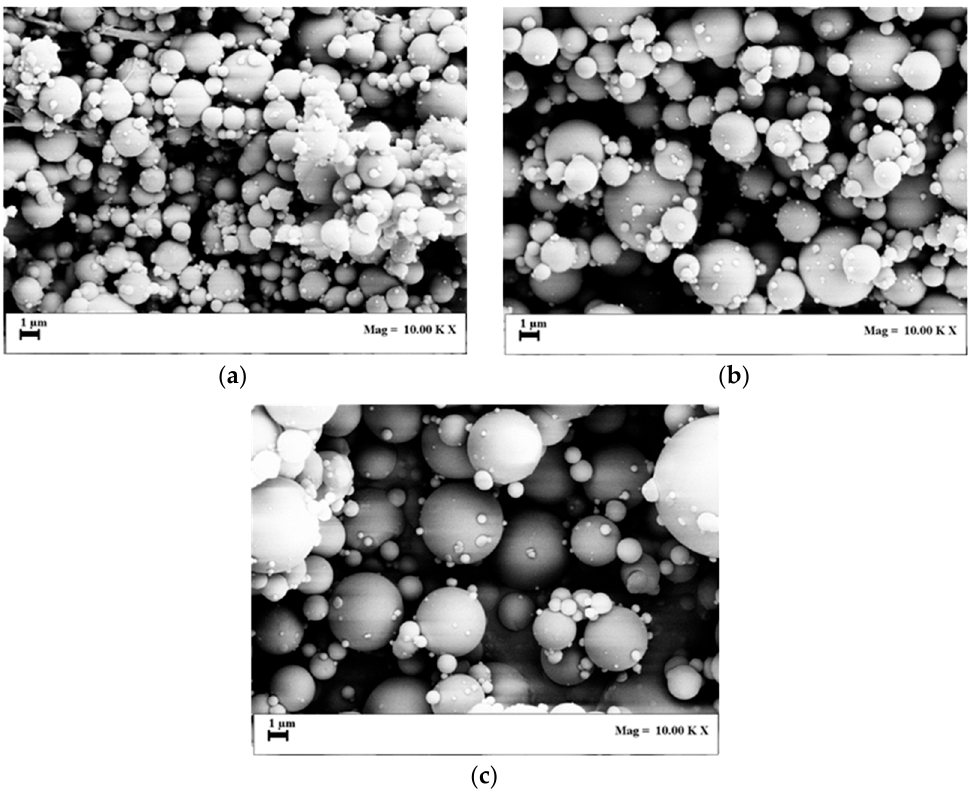
Figure 4. SEM images of PVP particles produced at 120 bar: ( a ) 2% w/w PVP, ( b ) 3% w/w PVP and ( c ) 5% w/w PVP.